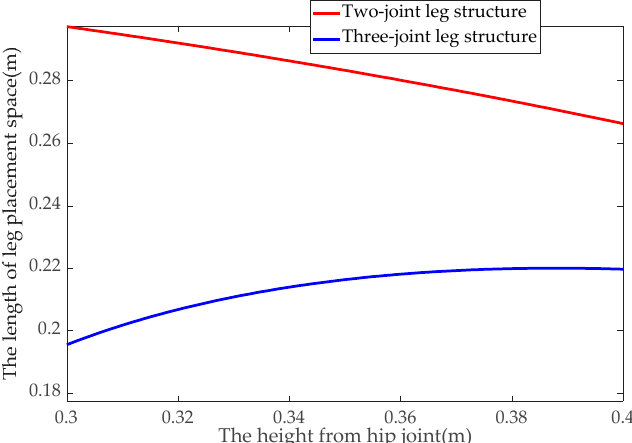
Figure 4. Occupied space after retracting the leg for the three-joint and two-joint leg structures.